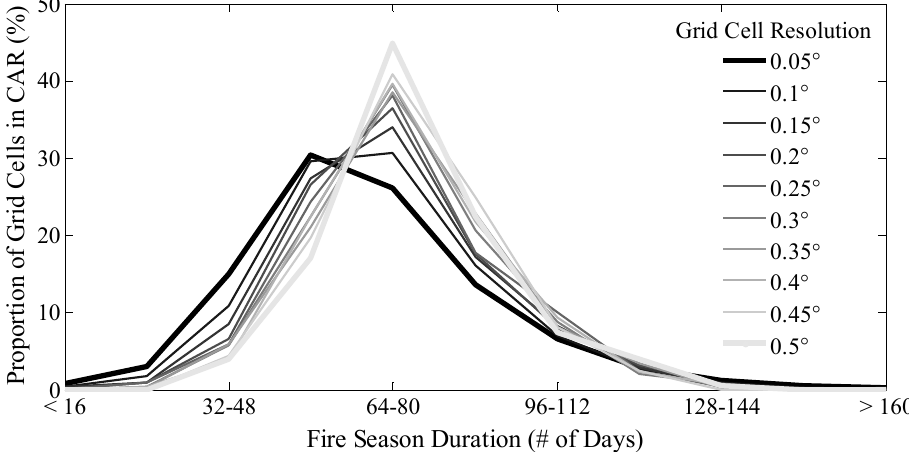
Figure 14. Preliminary results supporting our assertion that the characterization of fire season durations in the CAR would increase if fire pixels are accumulated into coarser grid cells. Distributions are constructed using MODIS active fire pixels